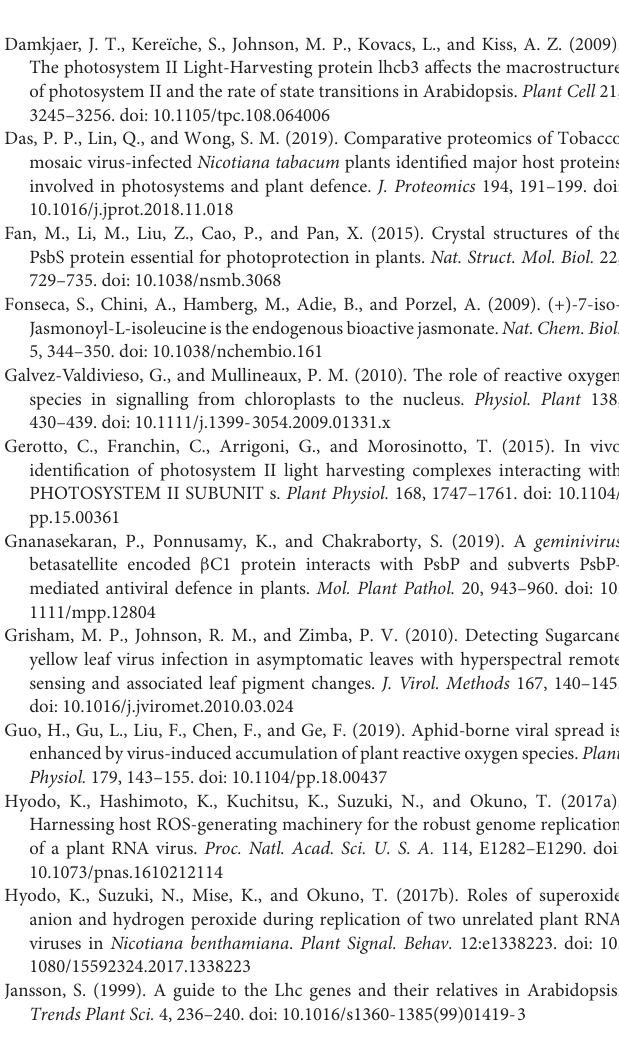
Supplementary Figure 1 | Sequence analysis and phylogenetic tree of LHCB homologs from different plant species. (A) Protein sequence alignment of NbLHCB3 and AtLHCB3. (B) Nucleotide sequence alignment of NbLHCB3 and AtLHCB3 cDNA fragments. (C) Phylogenetic tree of LHCB homologs from different plant species. NbLHCB3 is marked with red lines. Supplementary Figure 2 | Phylogenetic tree of NbLHCBs and relative expression levels of NbLHCBs in the TRV:LHCB3-inoculated plants. (A) Comparison of cDNA sequences and construction of phylogenetic tree of NbLHCBs . NbLHCB3 is marked with red lines. (B) Relative expression levels of NbLHCB family members in the TRV:LHCB3-inoculated plants. Bars represent the standard errors of the